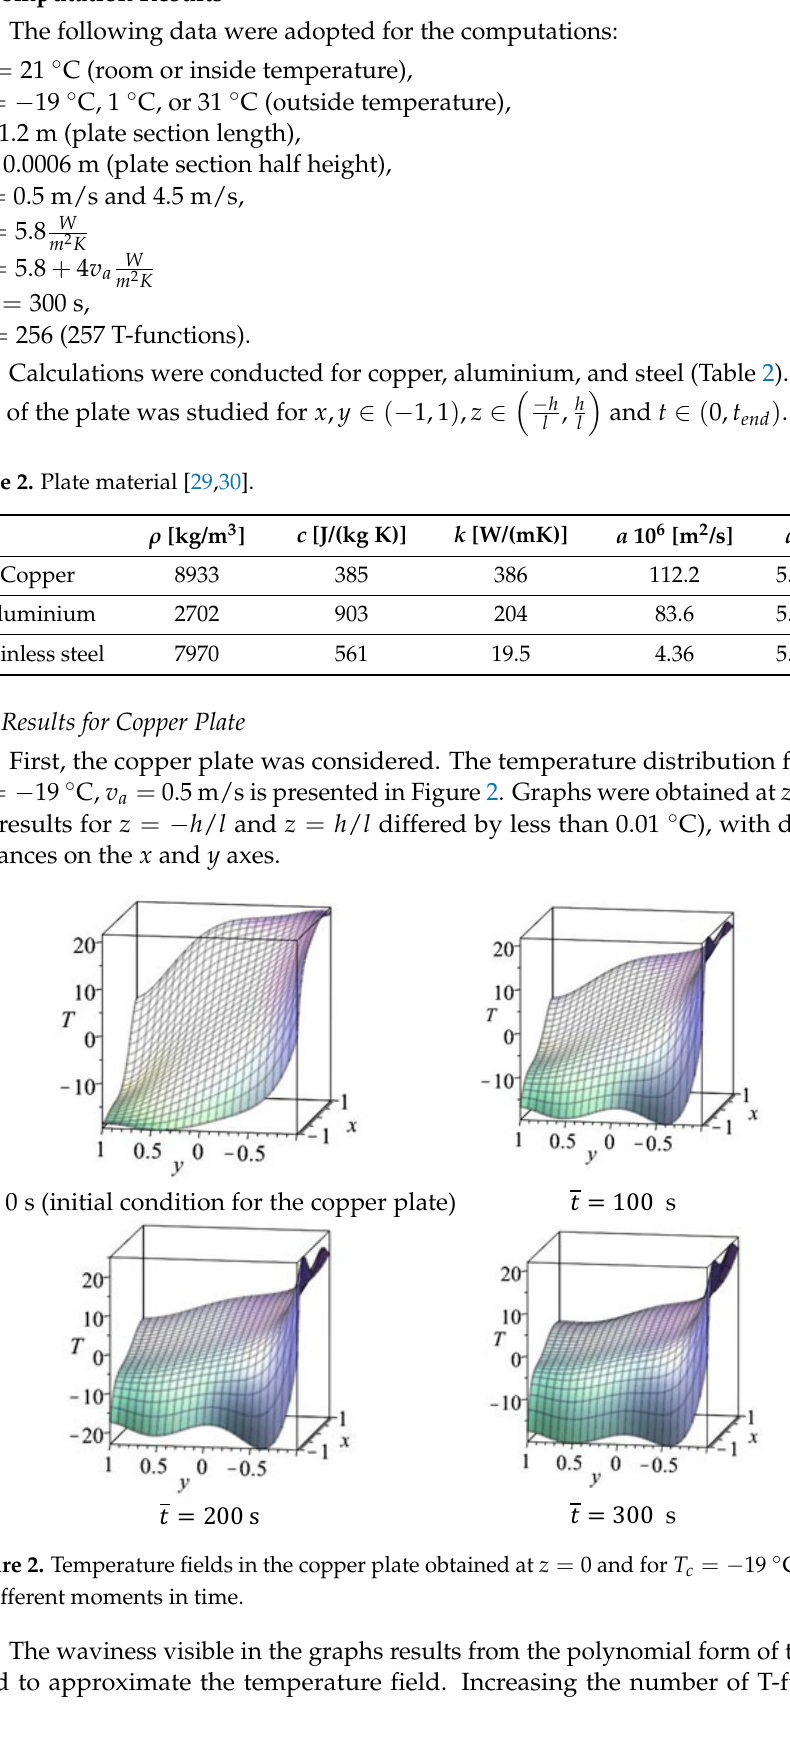
Figure 2. Temperature fields in the copper plate obtained at z = 0 and for T c = − 19 ◦ C, v a = 0.5 m/s, at different moments in time.